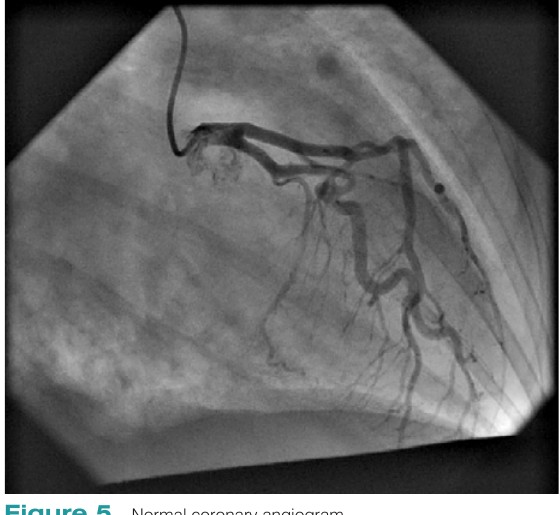
Figure 5. Normal coronary angiogram.